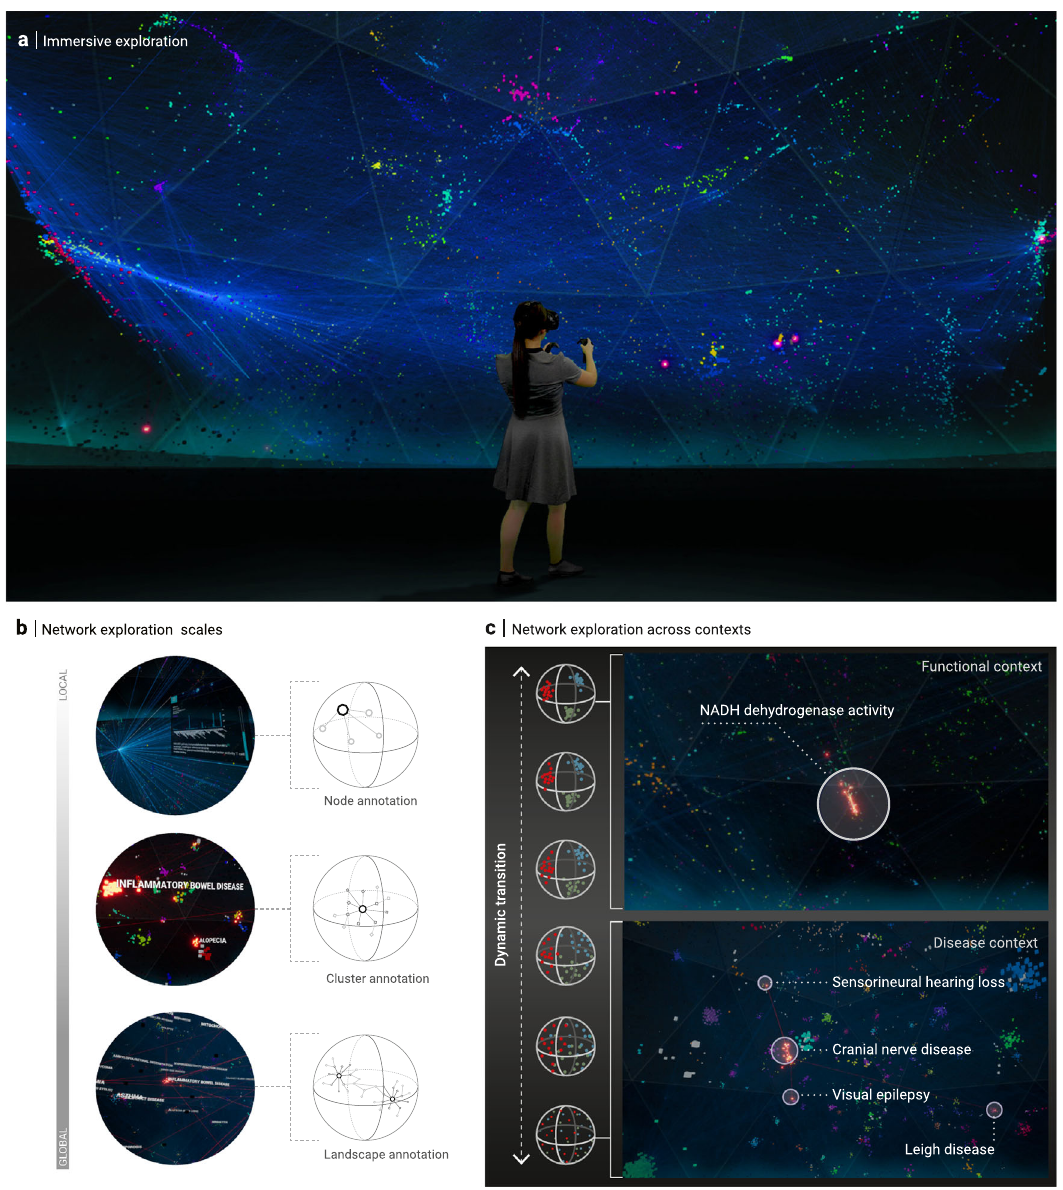
Fig. 2 Immersive network exploration. a Green-screen composition showing a user immersed in the genome-scale molecular interaction network. b Network annotations at different scales: individual nodes are annotated with detailed information shown in a separate inspection panel. Meso-scale node clusters (representing, for example, biological functions or disease-associated processes) are annotated using fl oating labels derived from gene set enrichment and network proximity. Functional landscapes represent global network views in which neighborhoods and their respective annotations are highlighted. Our platform includes functional landscapes for gene annotations according to gene ontology (GO) and disease associations. c The dynamic transition functionality allows for exploring different roles of a particular gene or gene set across different contexts. Starting, for example, in a functional landscape showing the biological processes that a gene set is involved in (here: NADH-dehydrogenase activity; top panel), the positions of all nodes smoothly transition toward a functional landscape that highlights disease neighborhoods in which the respective genes are